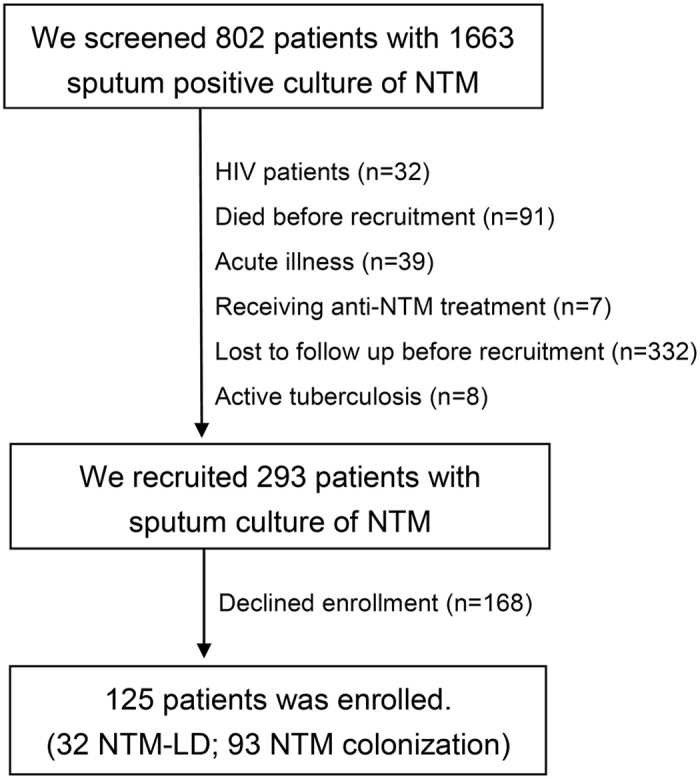
Flow chart of screening and enrolling participants with sputum positive for nontuberculous mycobacteria (NTM).Because enrolling period and parent population of the control group are not the same as participants with NTM in sputum. We did not describe the control group in the flow chart. LD, lung disease.